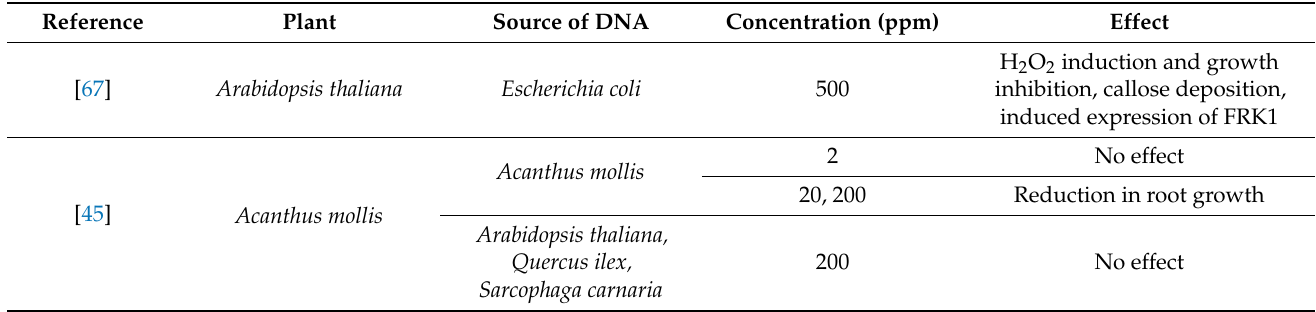
Table 2. Summary of effects of applied eDNA experimentally